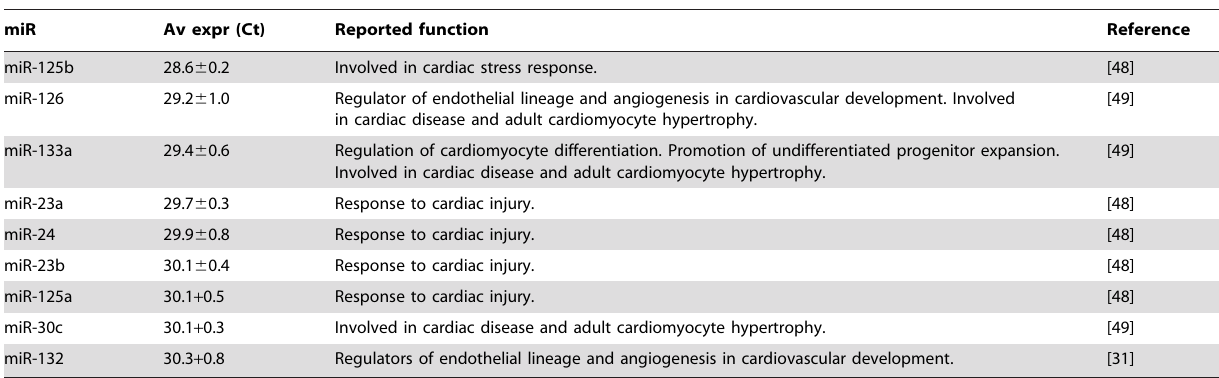
Table 1. Top 10% expressed miRs in adult CSCs.